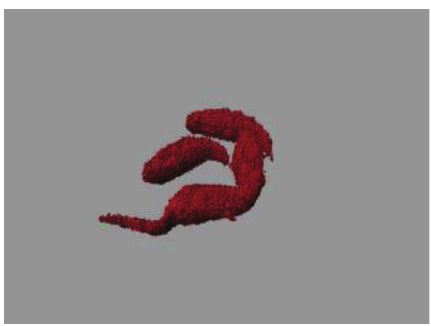
Figure 6: Confocal image of anti-sialyl-Tn REDantibody targeting glycan structures on the surface of T. cruzi epimastigotes. Figure adapted from Markiv et al. Module based antibody engineering: a novel synthetic REDantibody